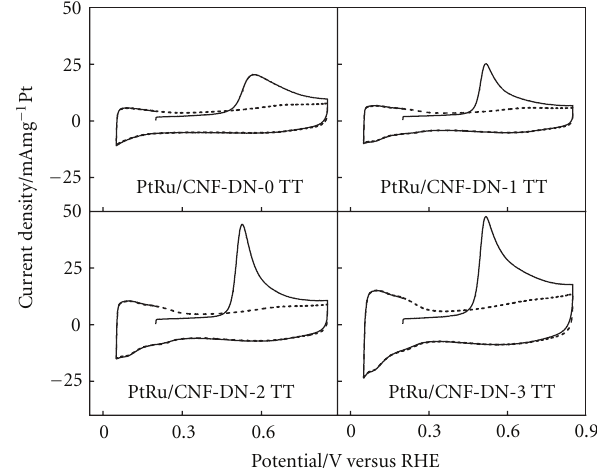
Figure 5: Cyclic voltammograms for CO oxidation at room temperature on the heat-treated synthesized catalysts. Full line: first scan. Dashed line: second scan. Scan rate: 20mVs − 1 . Supporting electrolyte: 0.5 M H 2 SO 4 . CO adsorption potential: 0.2 V versus